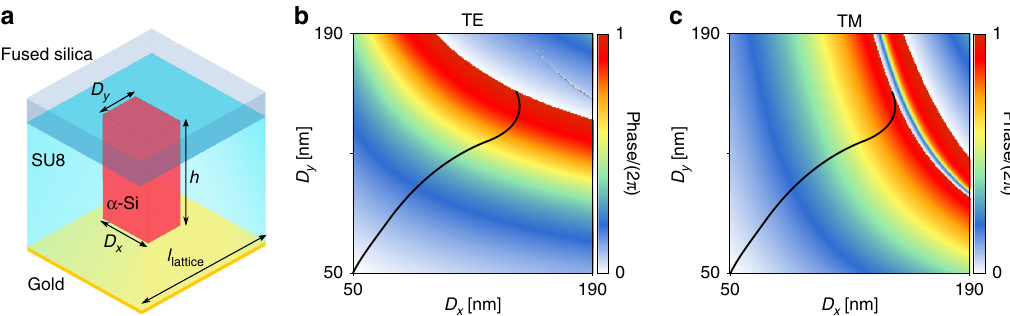
Fig. 3 Metasurface structure and design graphs. a Schematics of the re fl ective rectangular meta-atom. The meta-atom consists of α -Si nano-posts on a fused silica substrate, capped by a layer of SU-8 polymer and backed by a gold mirror. The nano-post is 395 nm tall and the lattice constant is 250 nm for the blazed grating and 246 nm for the focusing metasurfaces. b , c Simulated re fl ection phase plotted for TE and TM polarizations. The black curve highlights the path through the D x − D y plane that results in equal phases for the two polarizations. Nano-posts on this path were used to design the two focusing metasurface elements to make them insensitive to the input